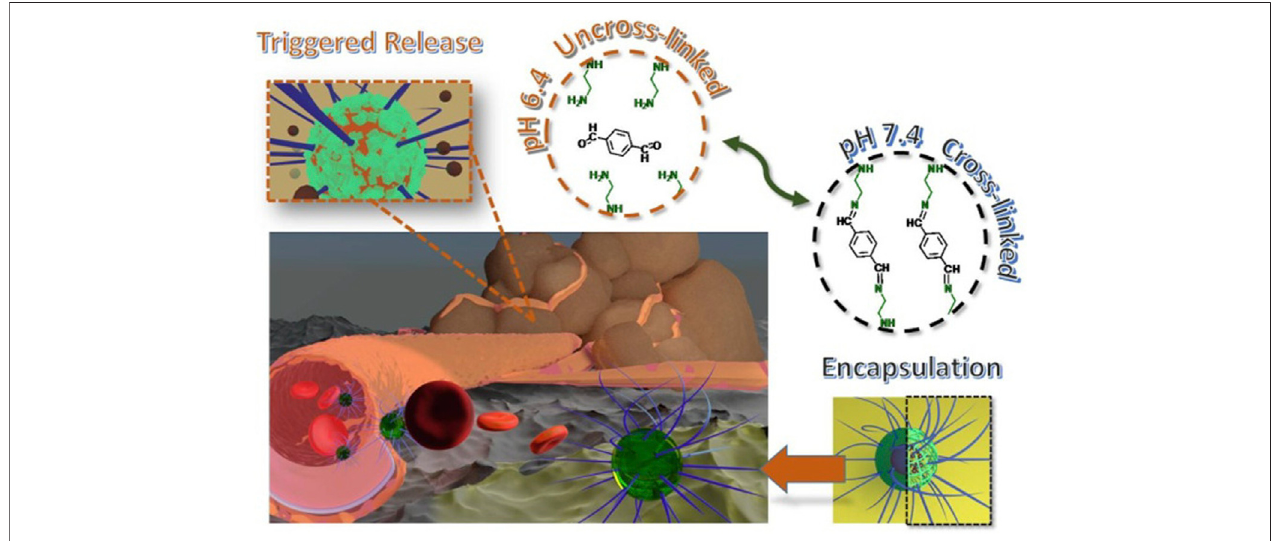
FIGURE 3 | Formation of pH-responsive mPEG-b-PNLG nanogels and the mechanism underlying drug delivery (Li Y. et al., 2018).